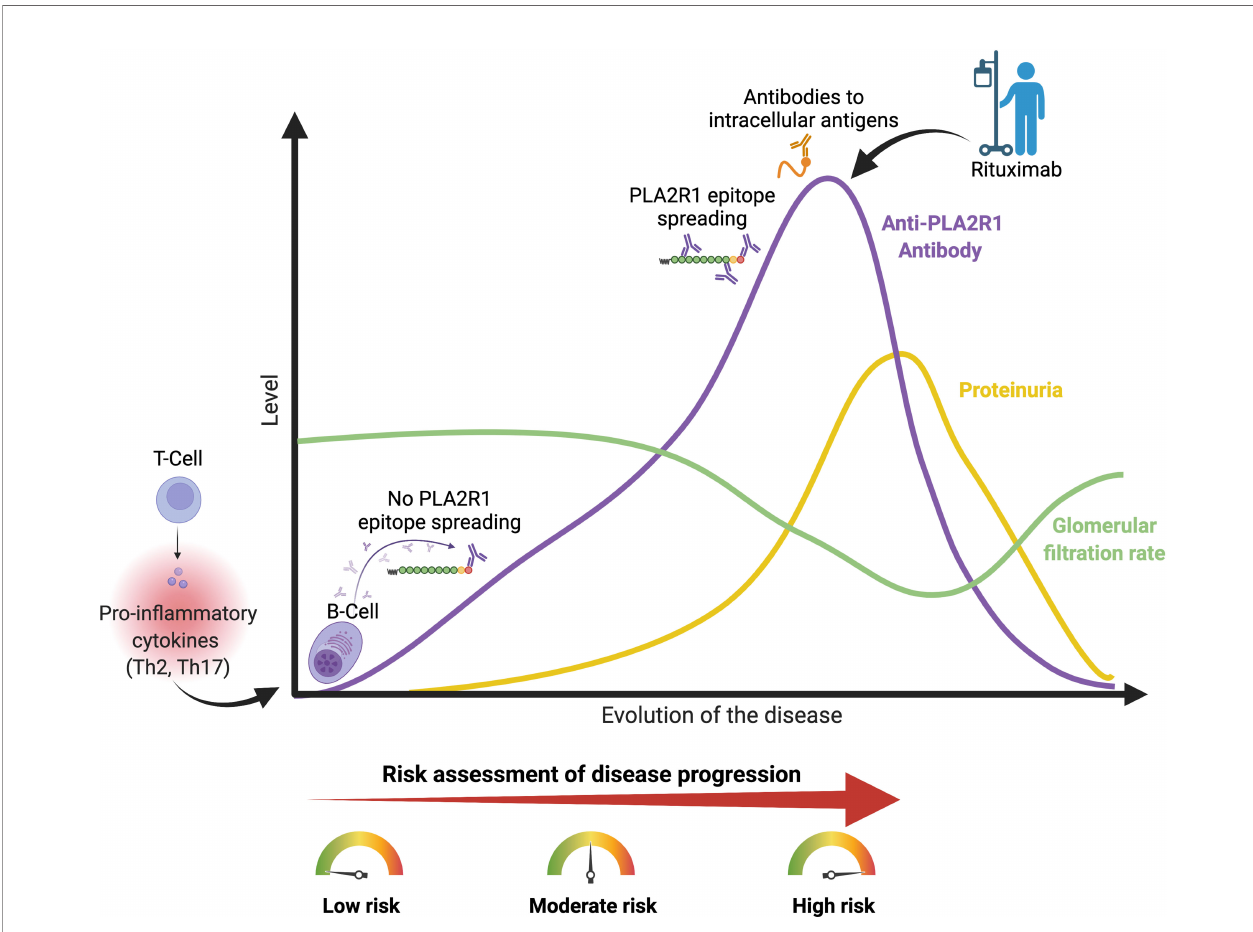
FIGURE 1 | Risk of disease progression in membranous nephropathy. PLA2R1, phospholipase A2 receptor type 1. Th2 and Th17 pro-in fl ammatory cytokines are increased in patients with pMN (13, 14). High anti-PLA2R1 antibody titer, positive epitope spreading, antibodies to intracellular antigens, high proteinuria despite optimal supportive care and deterioration of kidney function are associated with the risk of disease progression. Urine low-molecular-weight proteins and urinary IgG excretion have been shown to correlate with disease progression in patients with pMN, but these markers are rarely used in daily practice. Figure created with